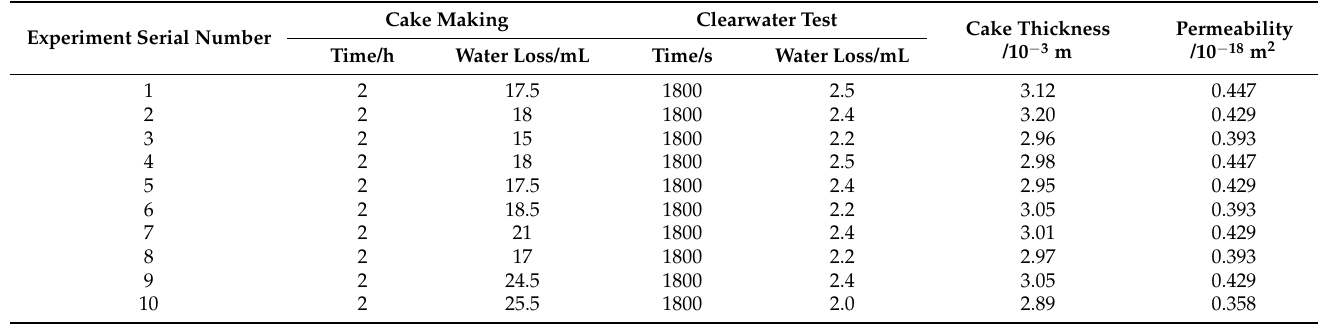
Table 4. Parallelism experiment of artificial filter